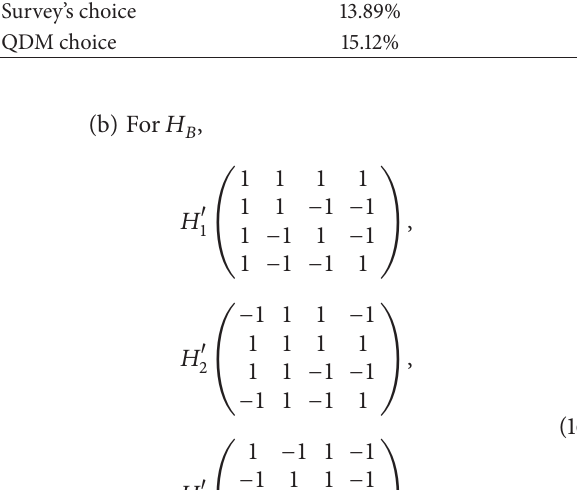
Table 6: The Game Theory prediction, survey result, and experiment results using QDM on The Price is Right. Offer 1000$ 2000$ 3000$ Survey’s choice 13.89% QDM choice 15.12%